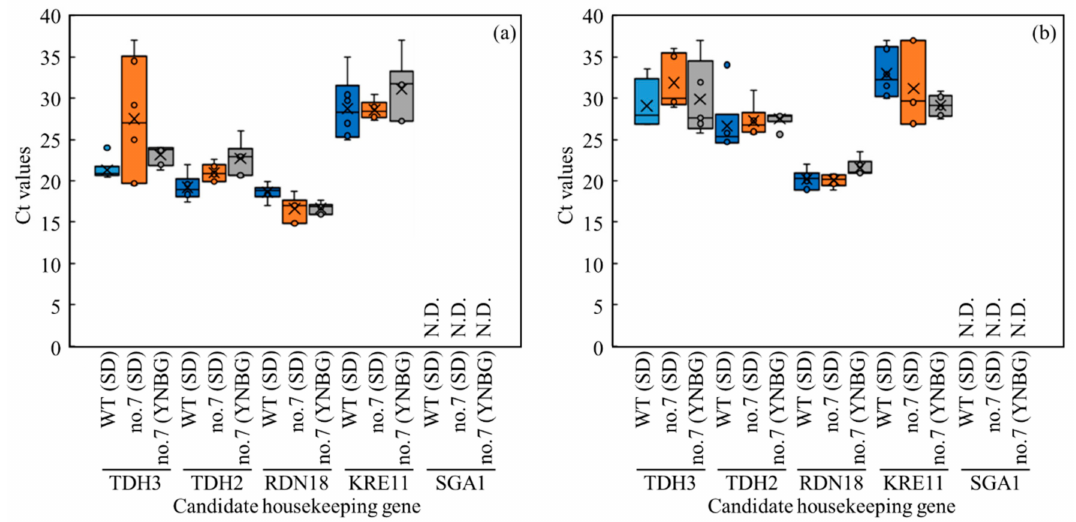
Figure 4. Distribution overview of transcription levels shown as Ct values of candidate genes as housekeeping genes in no.7 and wildtype. Boxplot representation of raw Ct values obtained from amplification curves ( n = 6). Lower and upper boundaries of the box indicate the 25th and the 75th percentiles, the thin line within the box marks the median, and the whiskers (error bars) below and above the box indicate the 10th and 90th percentiles, respectively. CT values were obtained under ( a ) aerobic and ( b ) anaerobic